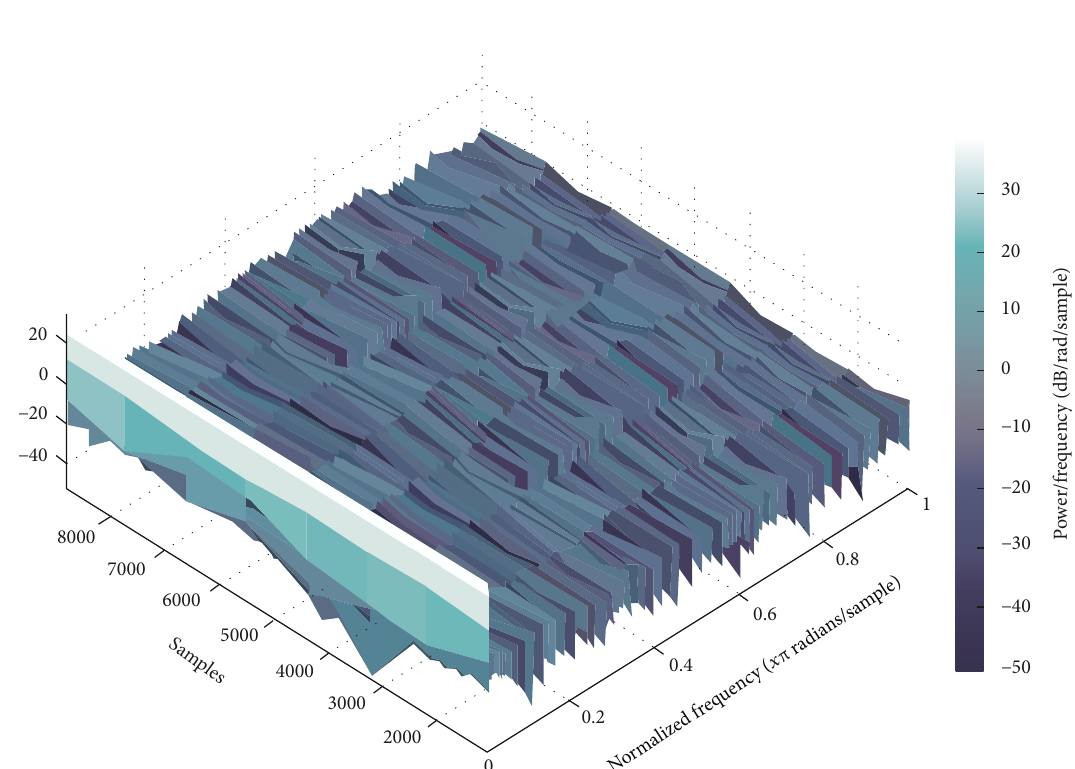
Figure 8: Spectrogram of 3d wind time